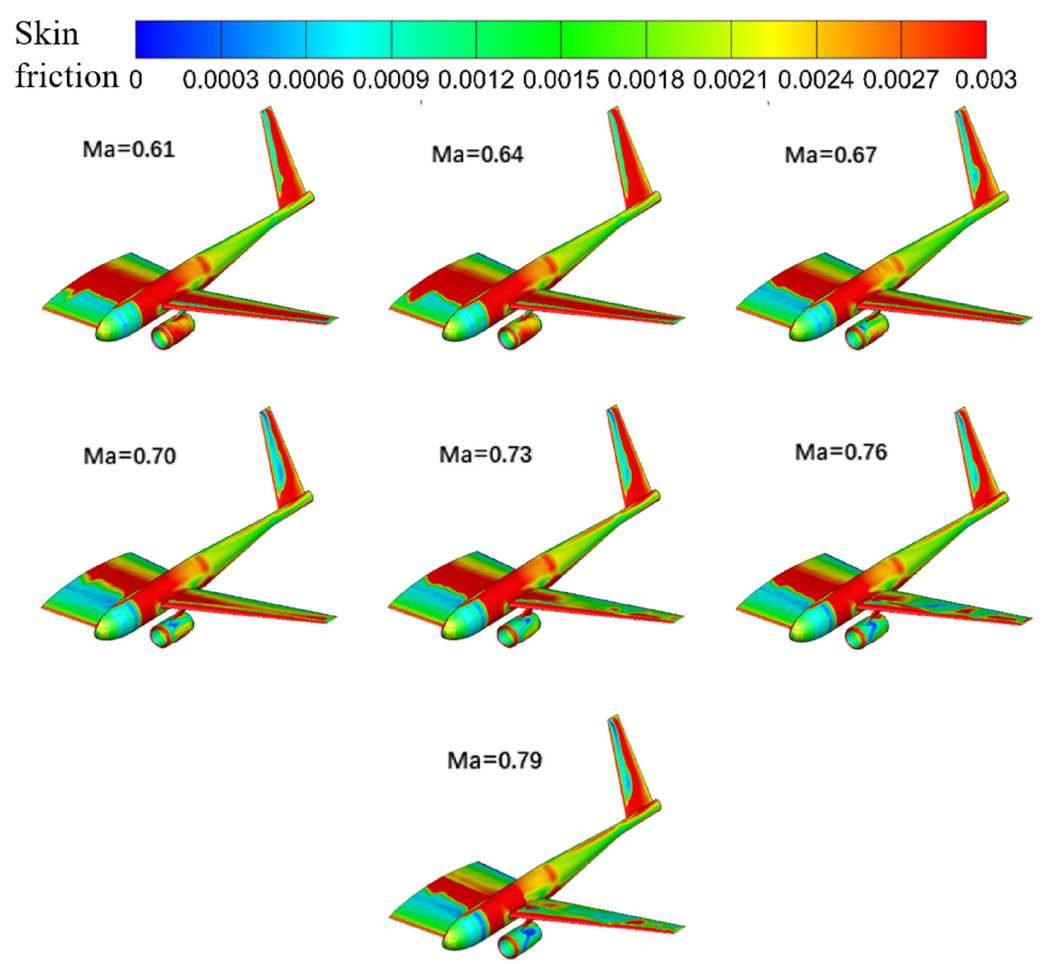
Figure 17. Skin friction coefficient contour of the whole aircraft with different Ma .